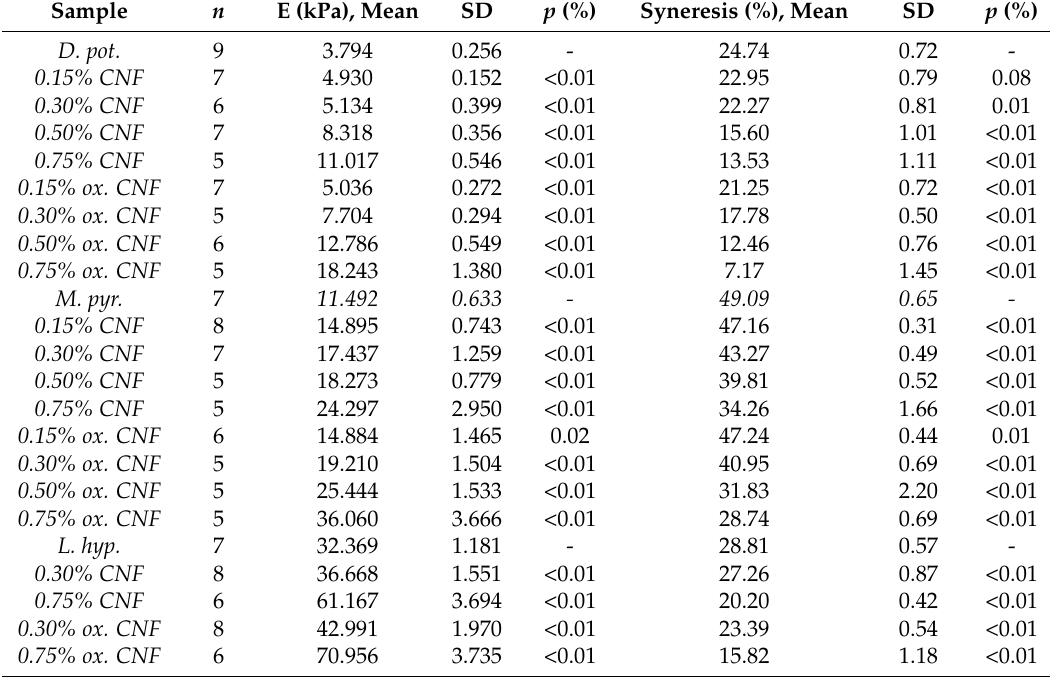
Table A3. Statistical outcomes, Figure 1: E = Young’s modulus, standard deviation (SD), number